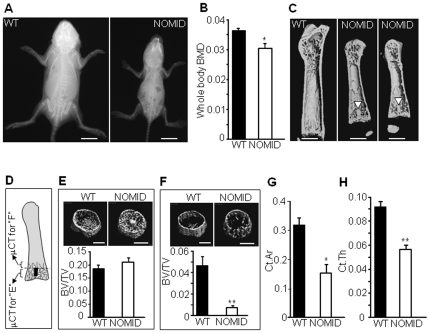
NOMID mice exhibit stunted skeletal growth and reduced bone mass.X-ray radiography (A), DXA (B) or μCT analysis of the femur (C, E–H) of NOMID and WT mice at age P13. DXA and μCT 3D reconstruction revealed generalized osteopenia and the presence of a tissue spike across the growth plate (C, arrowhead) in 2 NOMID mice. (D) The metaphyseal region containing (E) or contiguous (F) to the spike (depicted in black in Fig. 3D) where trabecular bone volume (BV/TV) was quantified. BV/TV was unchanged in the metaphyseal region that included the spike, but was decreased in the region contiguous to this structure. NOMID mice also exhibited significantly lower cortical area (G) and thinner cortical bone (H). Quantitative data were obtained from 5–6 mice/genotype and expressed as the mean ± S.E.M. *P<0.05; **P<0.007. BMD, bone mineral density.